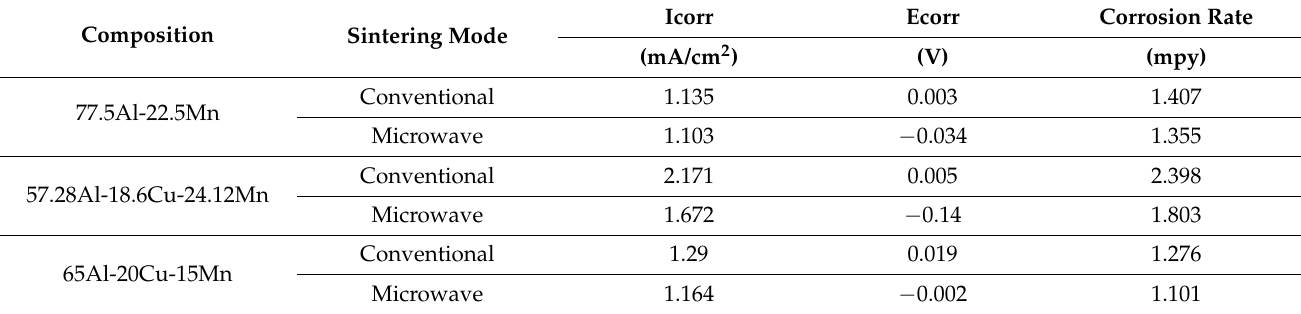
Table 6. Passivity parameters obtained for sintered compacts of Al-alloys of Cu and Mn from the anodic polarization study in 0.1N HCl. All the compositions were sintered at 550 ◦ C in a conventional as well as microwave furnace. Composition Sintering Mode